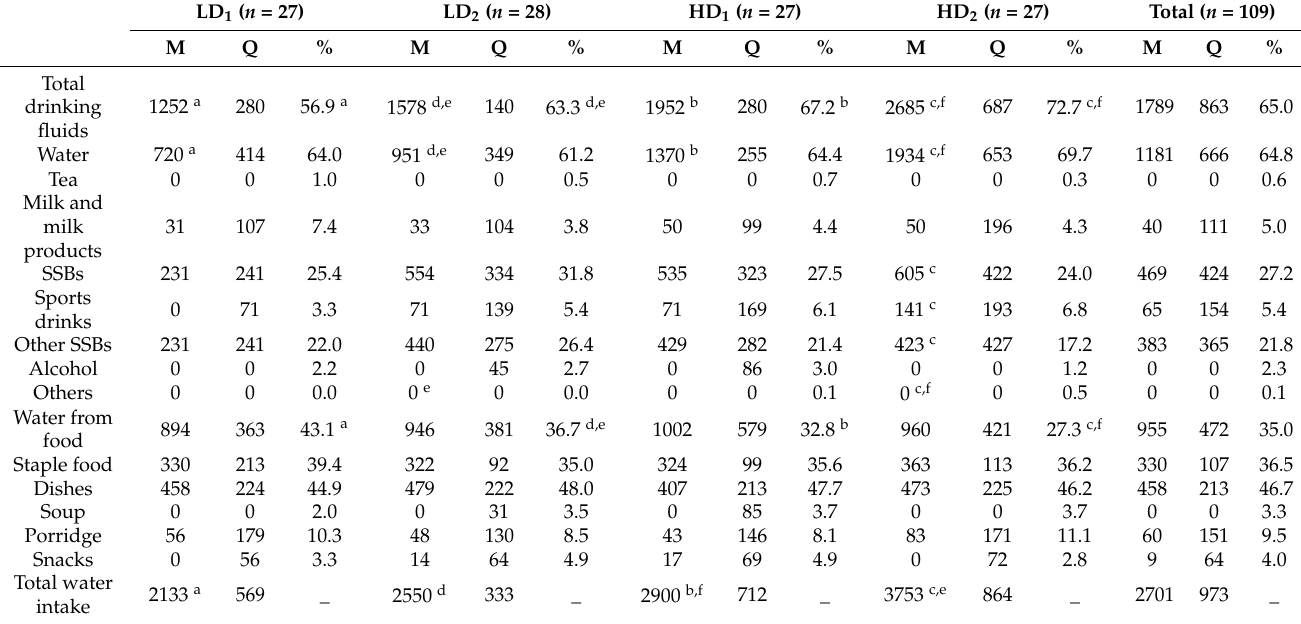
Table 2. The TWI, total drinking fluids, and water from food among participants consuming different levels of total drinking